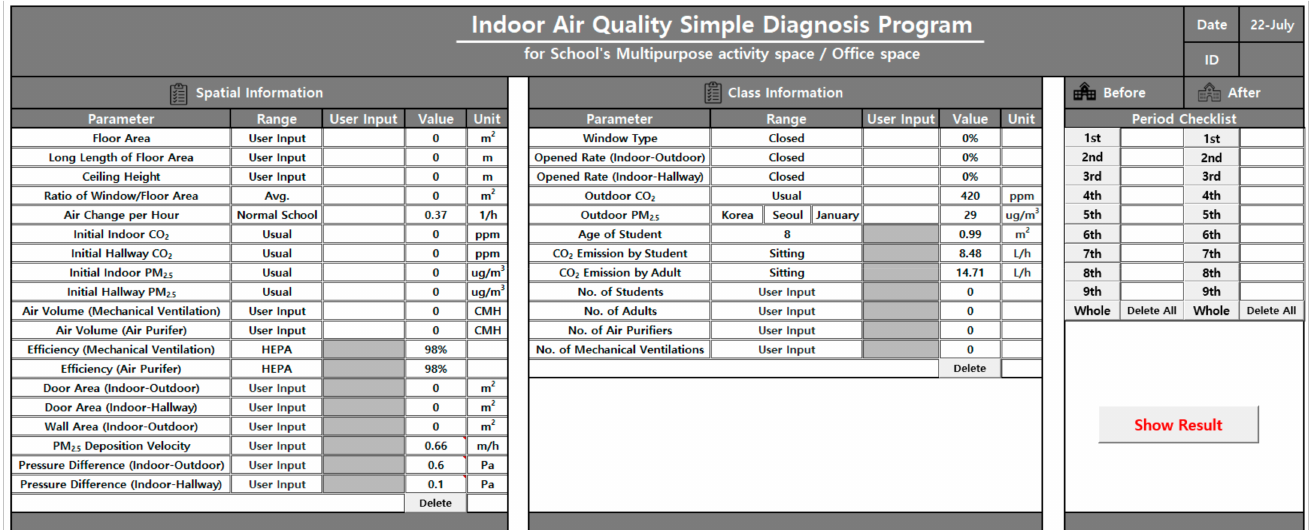
Figure 12. Input sheet for the simple indoor air quality diagnosis program for office and multipurpose activity spaces at